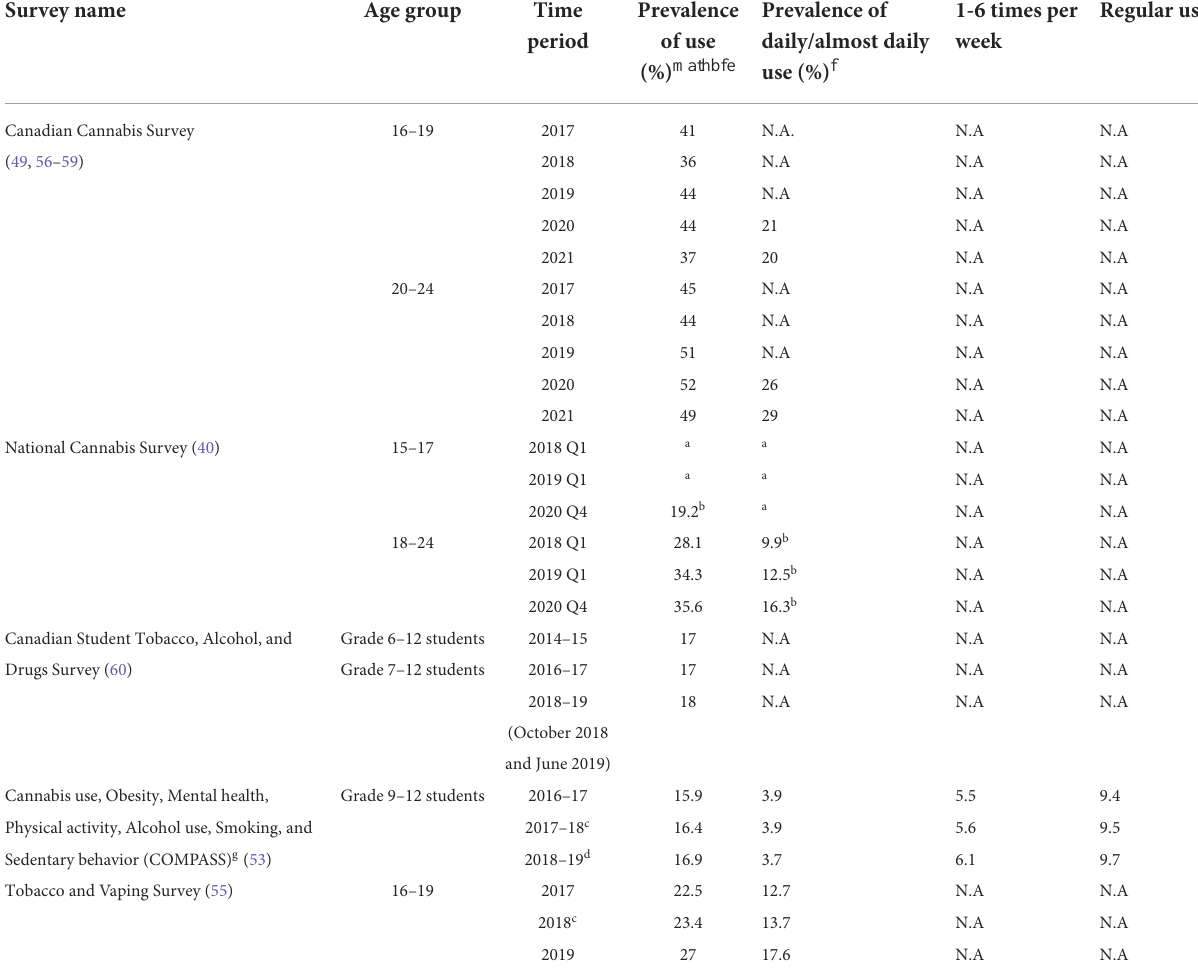
TABLE 2 The prevalence of Cannabis use in the Canadian youth population before and after